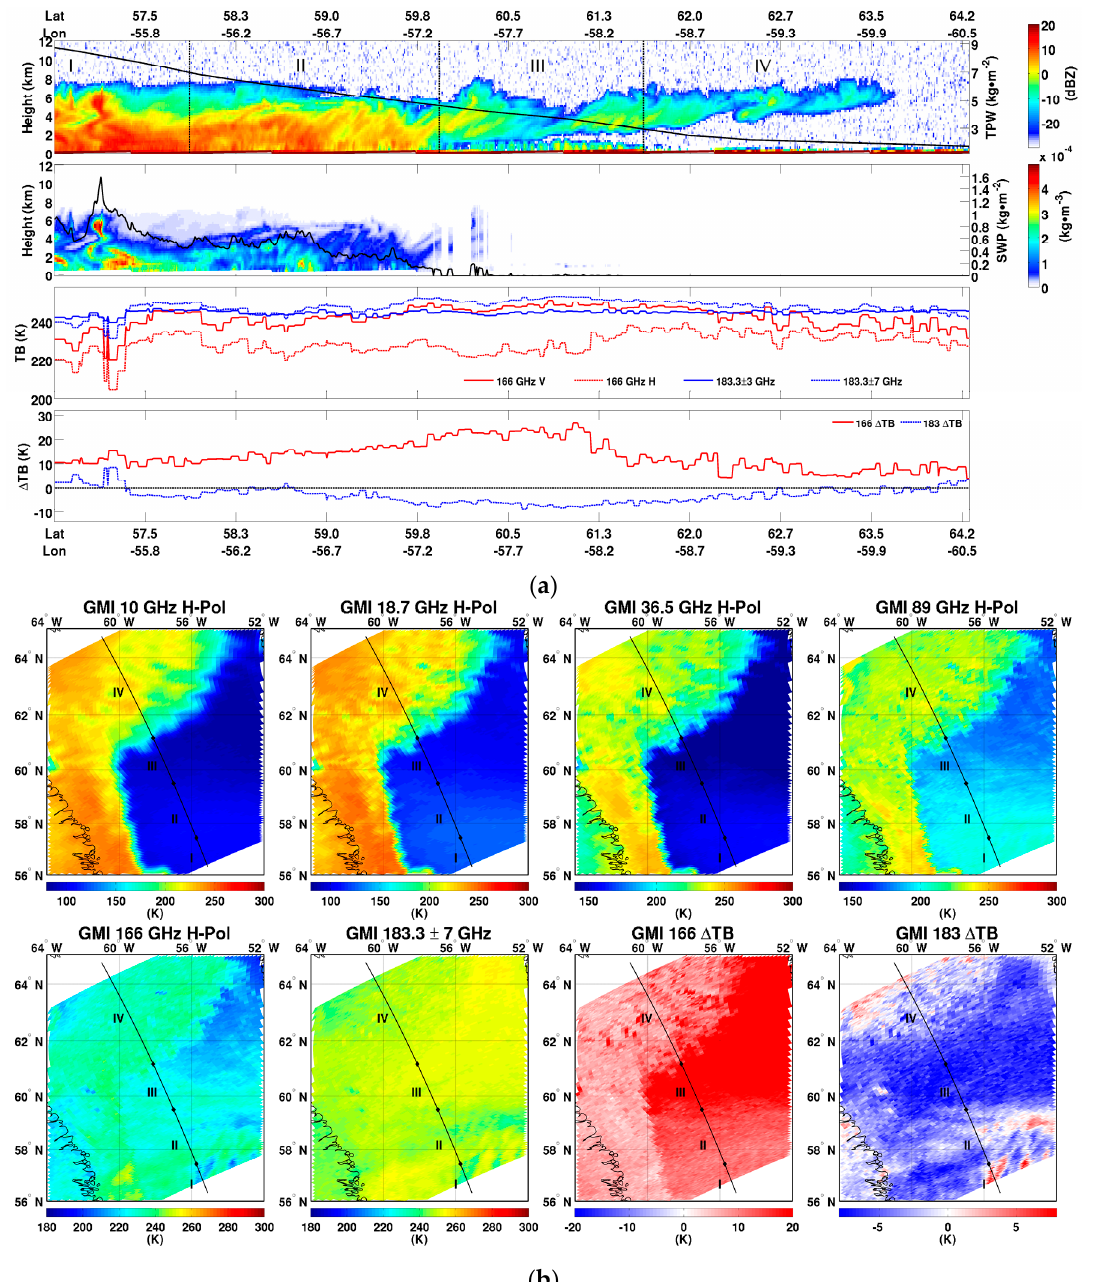
Figure 4. Synoptic snowfall event over the Labrador Sea on 27 March 2014. ( a ) Same as in Figure 2a; ( b ) Same as in Figure 2b.